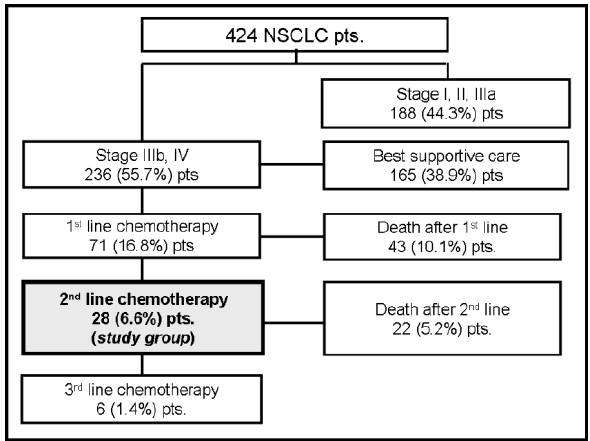
Figure 1: Flow diagram of treatment received by stage IIIb/IV non-small cell lung cancer patients The clinical characteristics of the 28 patients are listed in Table 1. The median age for all patients was 58 years (range, 37-69 years) and the majority were males (64%) and had a BMI of >18.5 kg/m 2 (72%), history of smoking (57%). The most common co-morbidity was hypertension (21%) and the most common symptoms at presentation were cough (93%) and dyspnea. The most common site of distant metastasis was brain in 21% of patients followed by bone in 7%. Table 2. The first-line chemotherapy was platinum-based combination in all patients with a median number of five cycles. As the first-line treatment, half of the cases received carboplatin-gemcitabine combination.